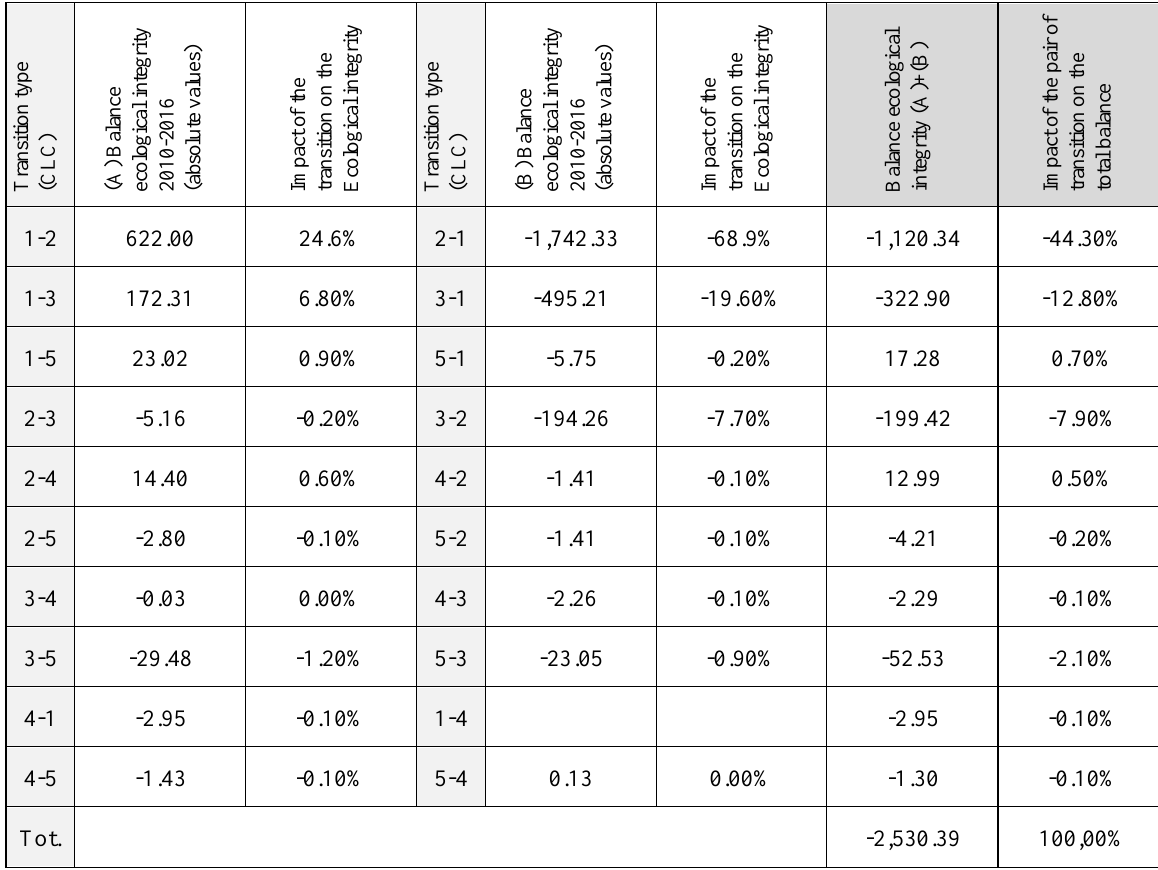
Table 6. Transition 2010-2016 of ecological integrity: contributions of transitions between different LULC classes at the first classification level.